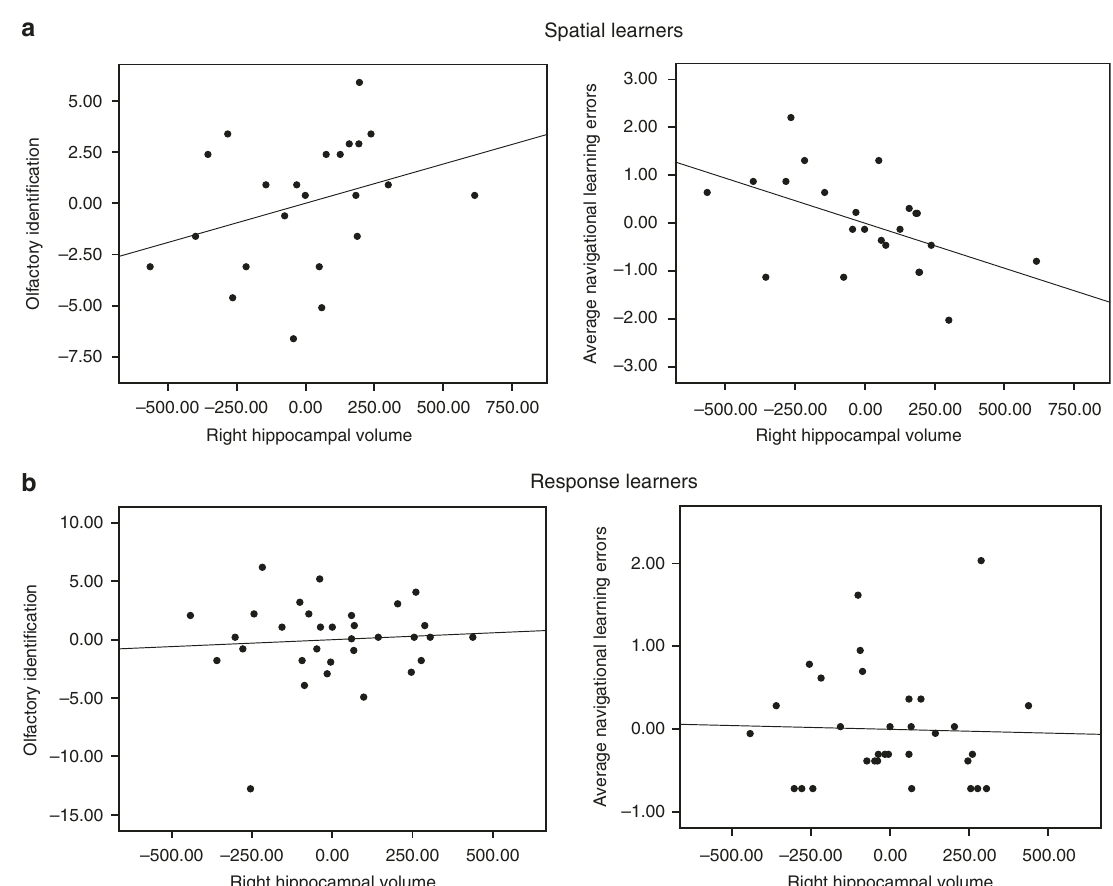
Fig. 4 Right hippocampal volume correlates with both olfactory identi fi cation and spatial memory. a We measured hippocampal volumes using MAGeT- Brain. Within spatial learners, there was a positive correlation between right hippocampal volume and olfactory identi fi cation (left) ( r = 0.32, Bootstrap BCa 95% CI [0.03, 0.60]), and a negative correlation between right hippocampal volume and average navigational learning errors (right) ( r = − 0.51, Bootstrap BCa 95% CI [ − 0.75, − 0.20]). b Within response learners, right hippocampal volume did not signi fi cantly correlate with olfactory identi fi cation (left) ( r = 0.08, Bootstrap BCa 95% CI [ − 0.32, 0.35]), nor with average navigational learning errors (right) ( r = -0.03, Bootstrap BCa 95% CI [ − 0.42, 0.28]). These results indicate that the relationship between olfactory identi fi cation, navigation, and hippocampal volume is speci fi c to those who use